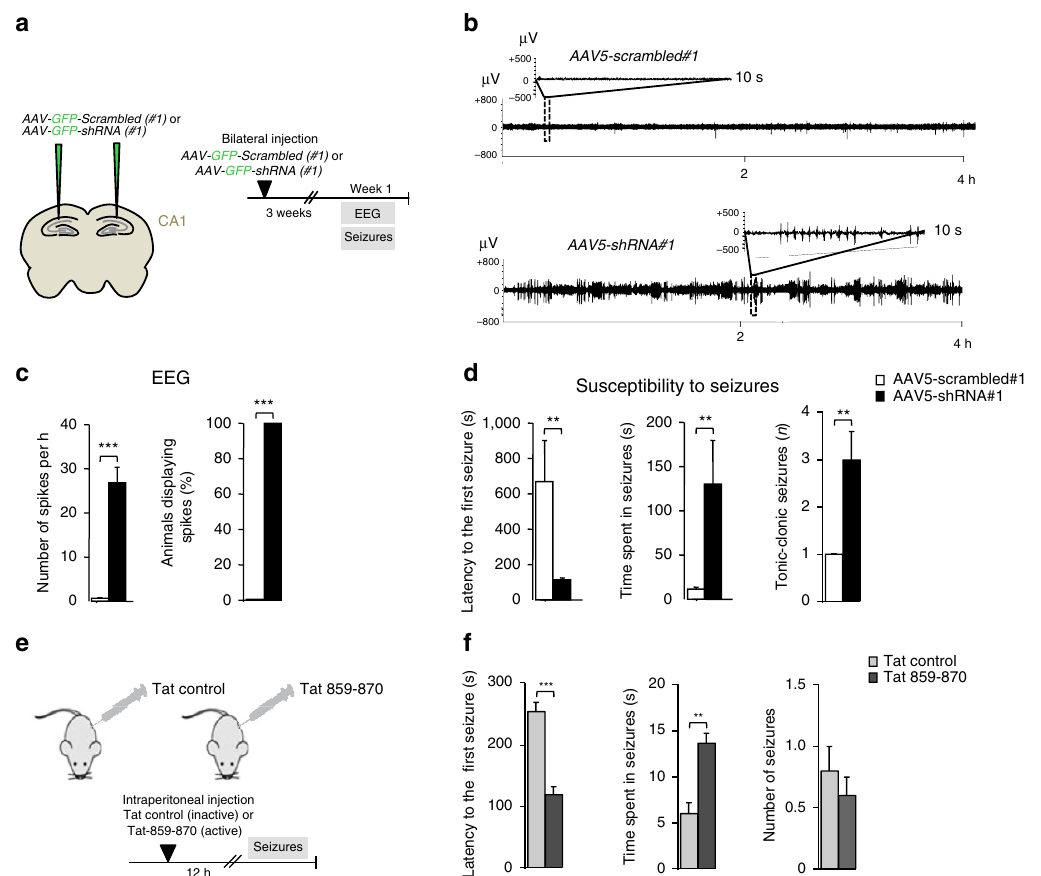
Figure 7 | Shrm4 silencing in vivo increases neuronal excitability. ( a ) Experimental design for investigating behavioural effects of Shrm4 silencing in rat hippocampal CA1. Rats were injected bilaterally with either AAV5-scrambled#1 or AAV5-shRNA#1 and tested after 3 weeks. ( b ) EEG recording in basal condition—two representative traces (4h recording) of basal cerebral activity in freely moving awake rats are shown. The traces of the AAV5-shRNA#1 rat showed abnormalities in term of presence of spikes of high amplitude compared with AAV5-scrambled#1 rat. The traces of the remaining AAV5-shRNA#1 rats showed similar patterns (data not shown). ( c ) Quantification shows higher number of spikes and an increased number of animals showing spikes in AAV5- shRNA#1-injected rats compared with AAV5-scrambled#1 rats. (number of spikes/hour: n ¼ 5, 5; *** P o 0.0001; t -test; animals displaying spikes: n ¼ 5, 5; *** P o 0.0001; t -test). ( d ) PTZ injection (45mgkg (cid:2) 1 i.p.) significantly decreased the mean latency to the first seizure and increased the mean duration of seizures and number of tonic-clonic (Racine scale 5) seizures evaluated for 30min in AAV5-shRNA#1 compared with AAV5-scrambled#1-injected rats (Latency to the first seizure: n ¼ 8, 9; ** P ¼ 0.0201; t -test; time spent in seizure: n ¼ 9, 8; *** P ¼ 0.0214; t -test; number of tonic-clonic seizures: n ¼ 9, 8; ** P ¼ 0.0069; t -test). ( e ) Experimental design for investigating the effect of intraperitoneal injection of the Tat-859–870 (active) peptide compared with the Tat control (inactive) on susceptibility to seizures. ( f ) The injection of the tat-859–870 given 12h before the test significantly increased the susceptibility to PTZ-induced seizures (45mgkg (cid:2) 1 i.p.) in terms of reduced latency to the 1st seizure (*** P o 0.001, n ¼ 3; t -test) and increased time spent in